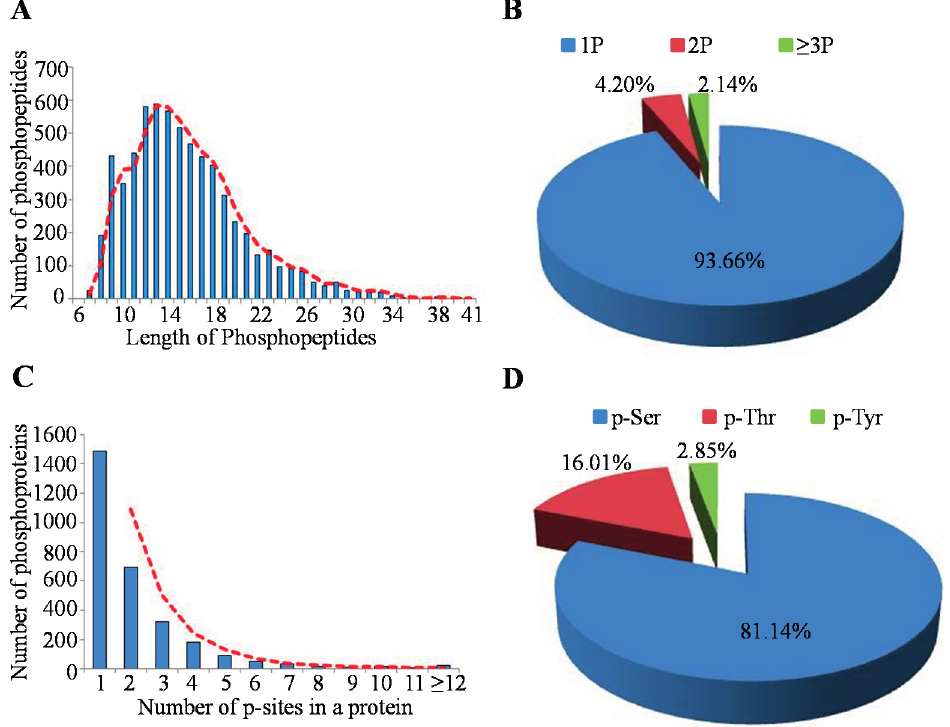
Figure 3. Characteristics of the identified unique phosphopeptides in the MHCC97-H cell line. ( A ) Distribution of phosphopeptides based on their length; ( B ) Distribution of phosphopeptides depending on their number of p-sites; ( C ) Distribution of phosphorylation proteins based on their number of p-sites; ( D ) Distribution of phosphorylation serine (p-Ser), phosphorylation threonine (p-Thr) and phosphorylation tyrosine (p-Tyr) sites in the MHCC97-H cell line